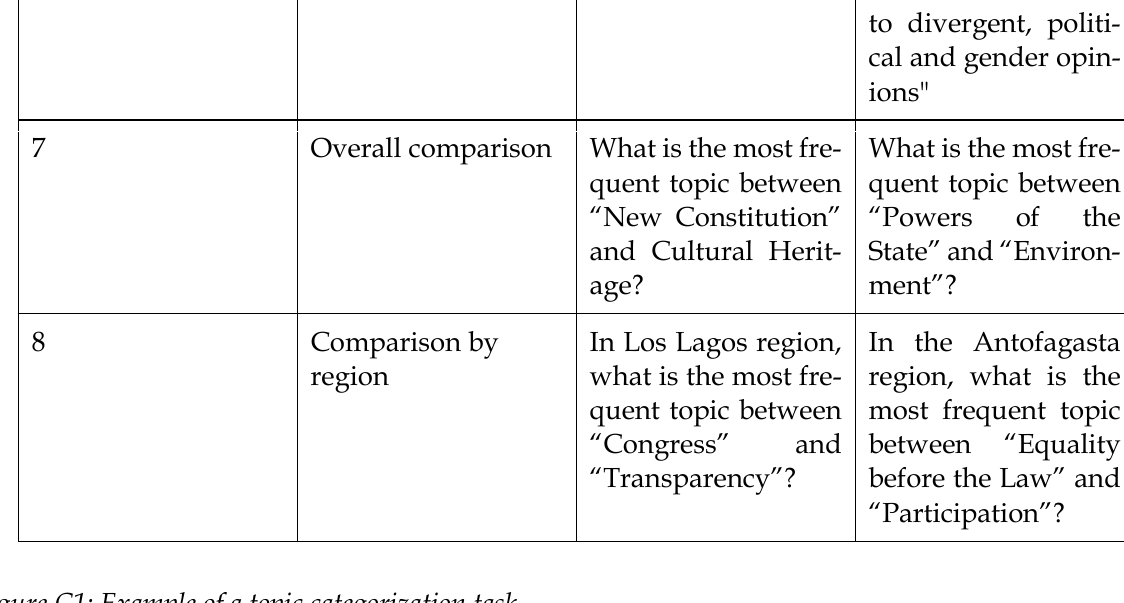
Figure C1: Example of a topic categorization